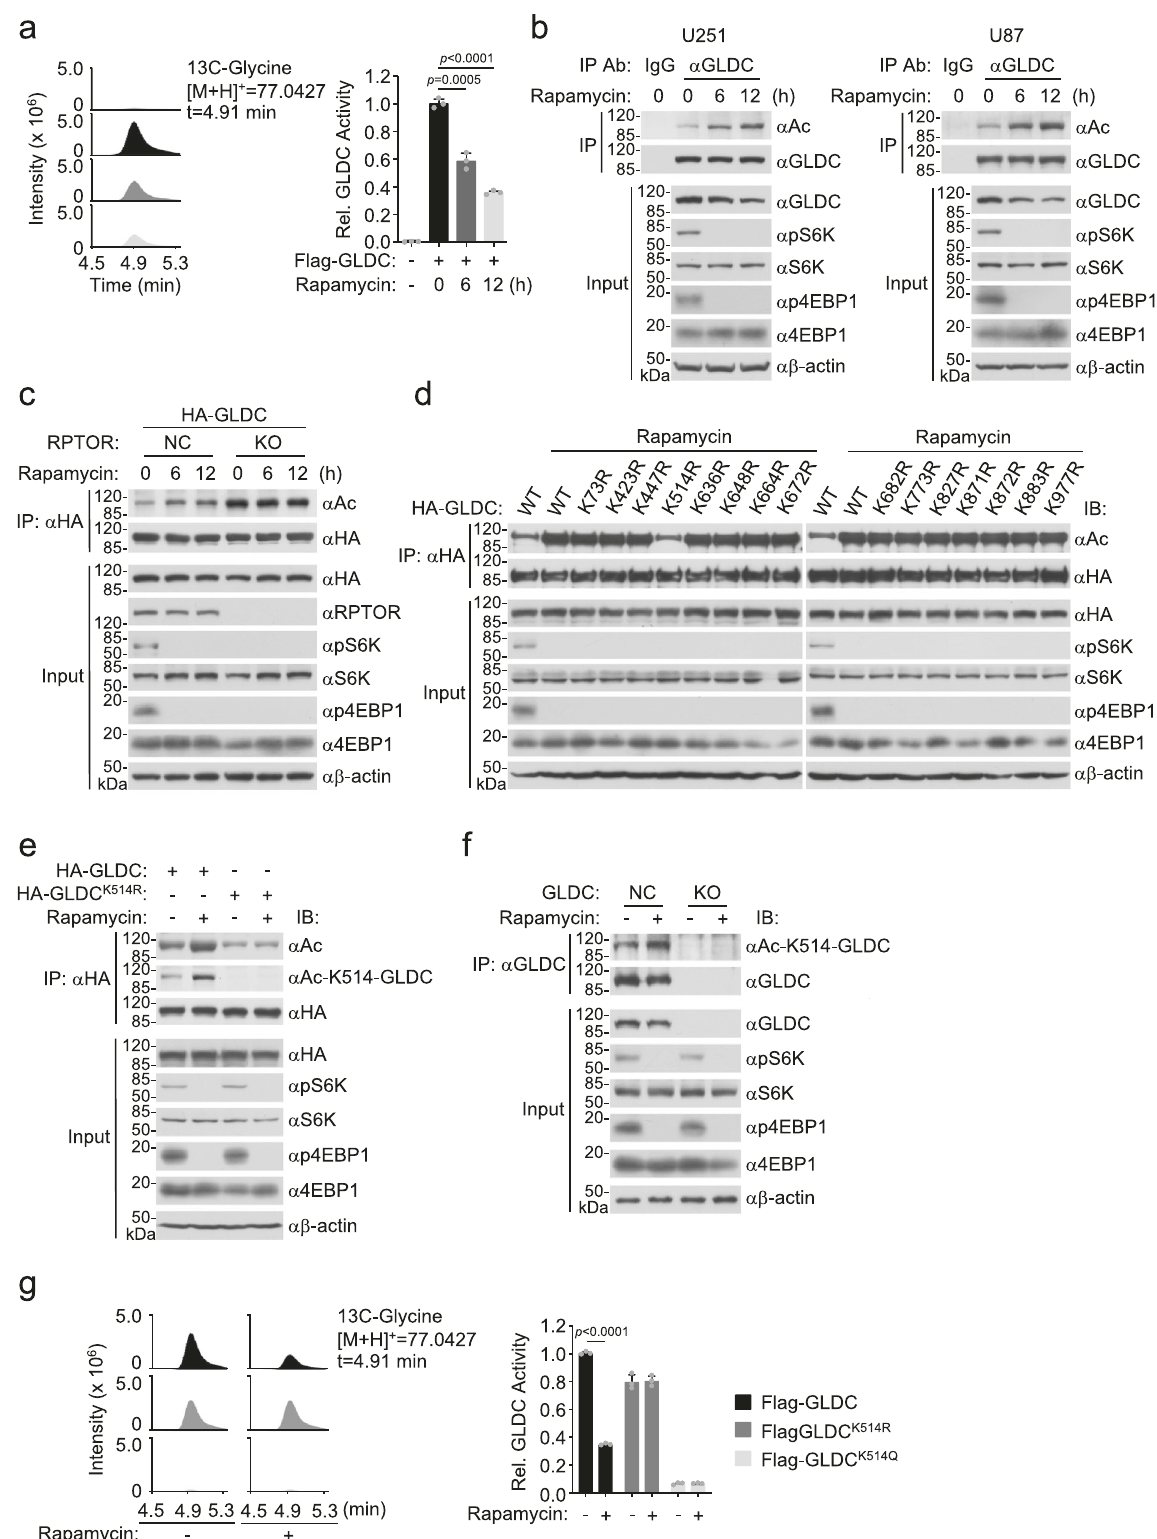
A (TSA, an inhibitor of HDACs) markedly increased GLDC K514 acetylation (Fig. 3a). Overexpression of SIRT3 but not the other 6 SIRTs reduced GLDC pan-acetylation (Fig. 3b). The enzymatic inactive mutant of SIRT3, SIRT3 H248Y , also lost its ability to inhibit GLDC K514 acetylation (Fig. 3c). In vitro assays con- fi rmed that SIRT3 but not SIRT3 H248Y mediated GLDC